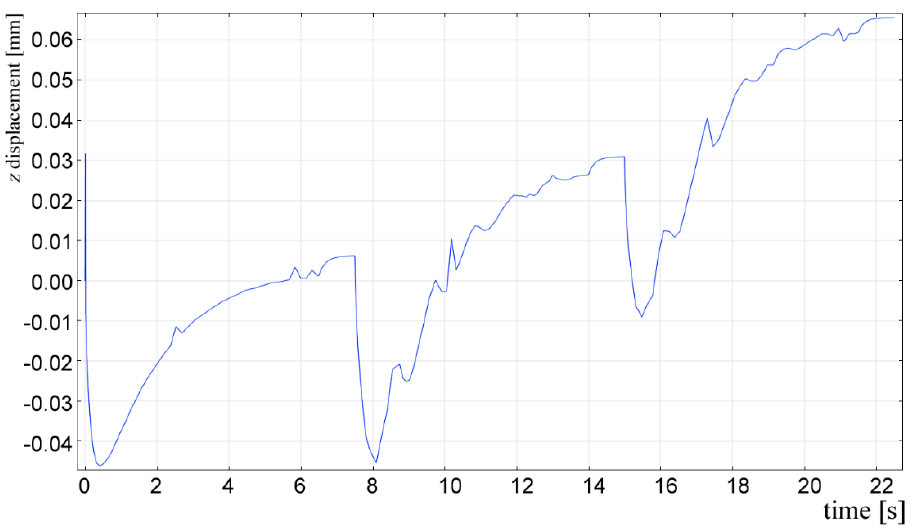
Figure 23. Displacement of the point of interest as a function of time; 3-track consecutive deposition strategy with no time delay.